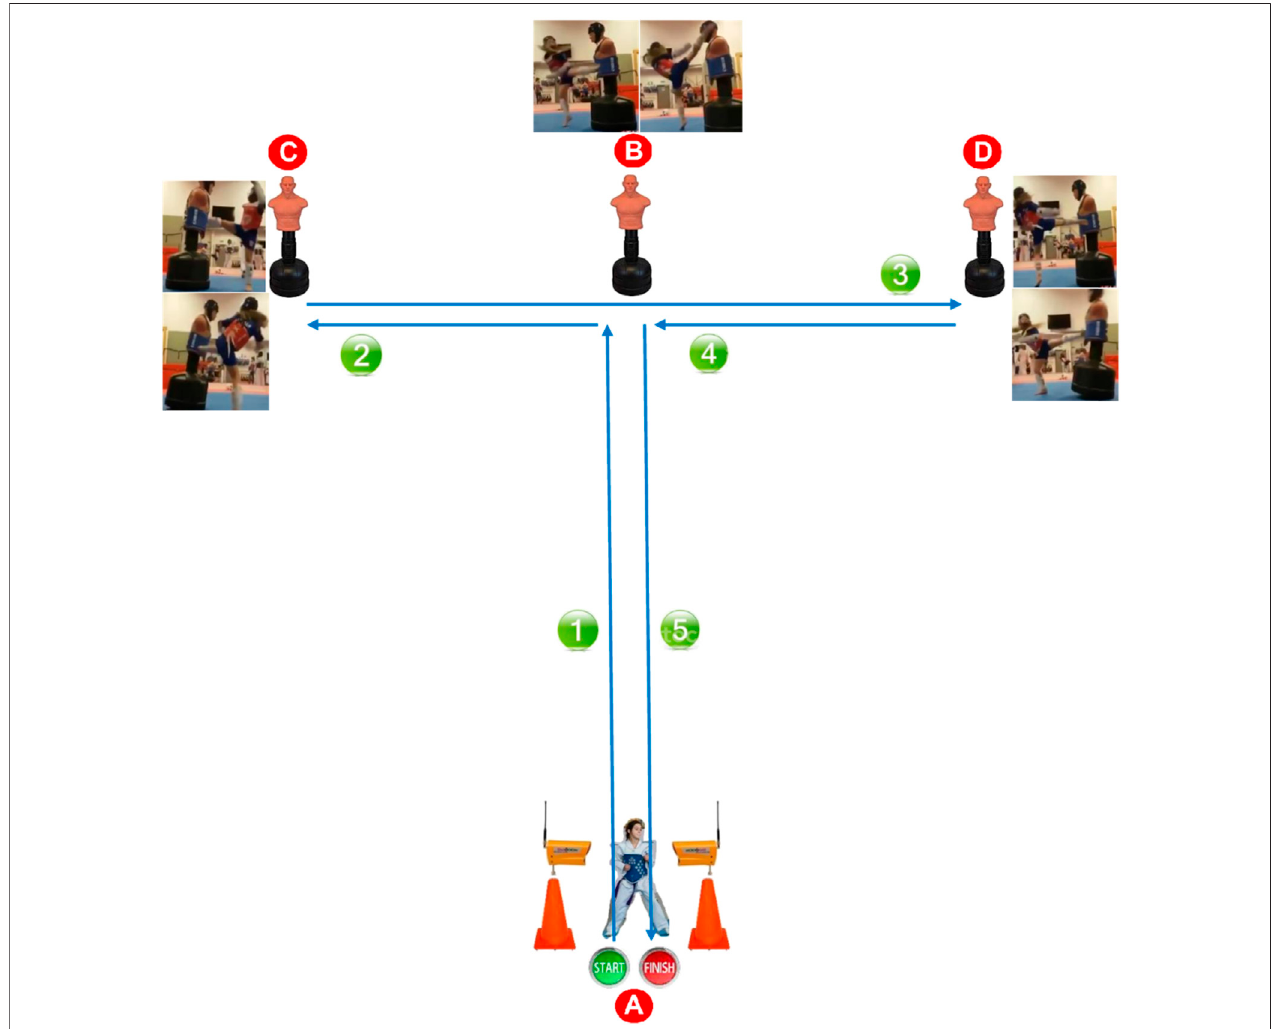
FIGURE 1 | Taekwondo speci fi c change-of-direction speed test with striking techniques (TST).